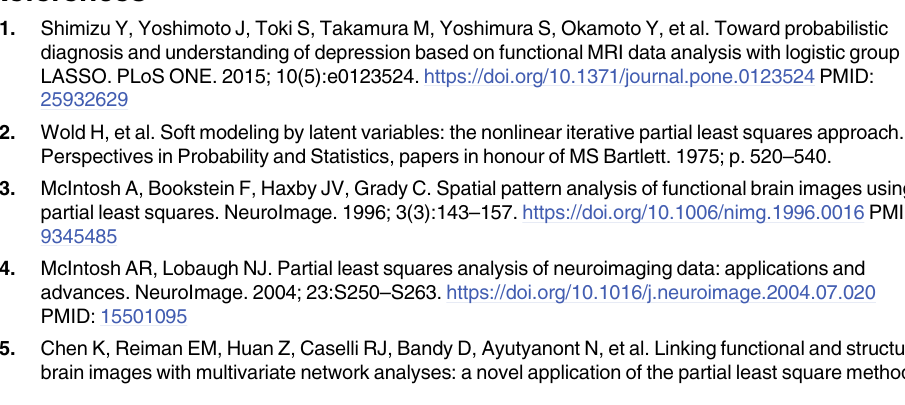
S6 Table. Root mean squared errors in extended AAL. Performance with the standard AAL outperformed extended AAL significantly. (adjusted for multiplicity using the Bonferroni- Holm method with significance level α =